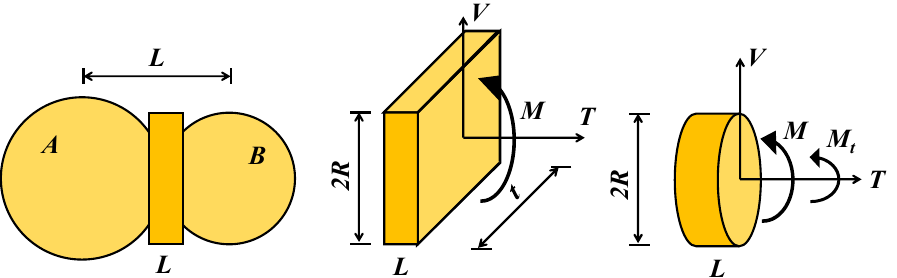
Figure 3. Parallel bond depicted as a finite-sized piece of cementitious material (modified based on [85]).